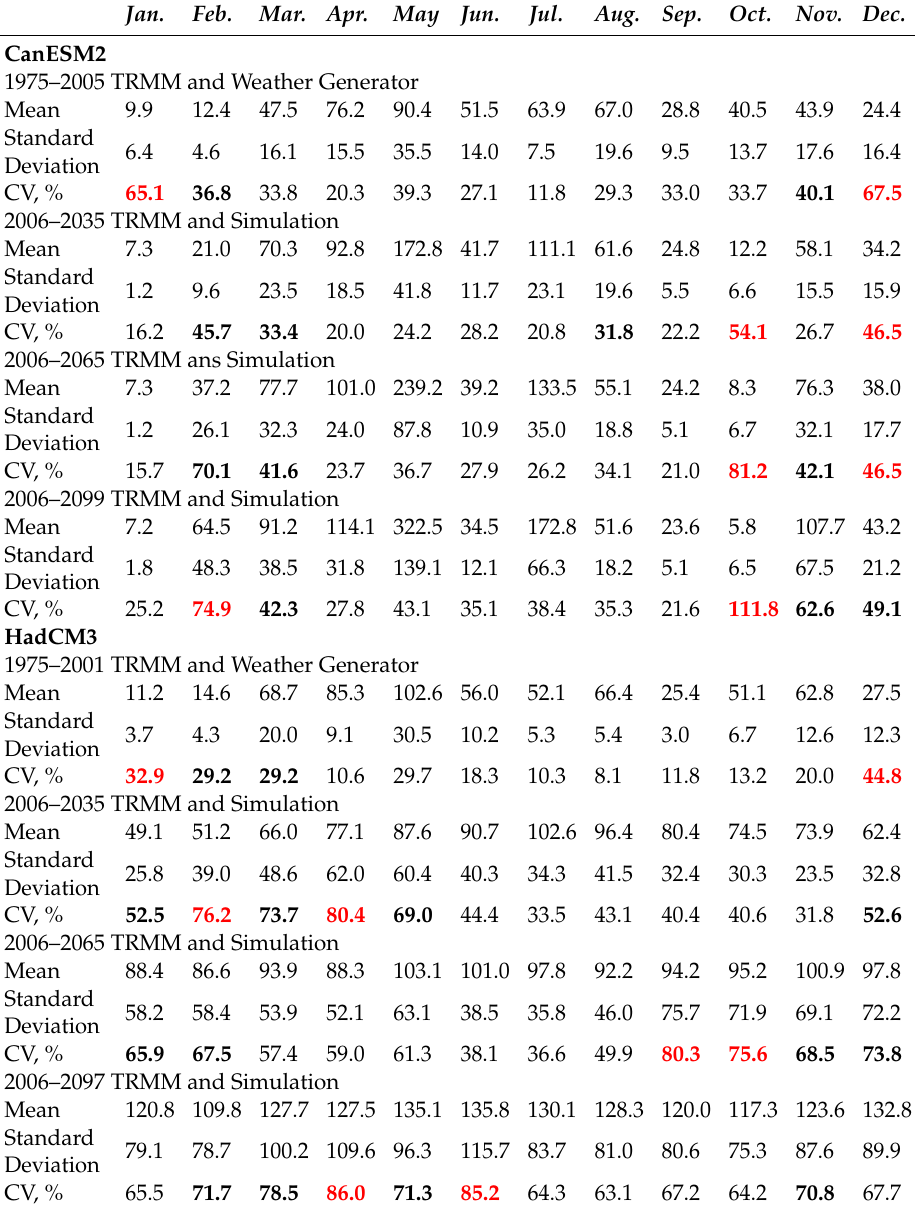
Table 7. Kaabong TRMM and Simulated (CanESM2and HadCM3) Monthly Rainfall Coe ffi cient of